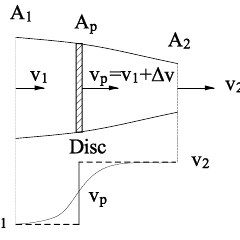
Figure 5. Schematic diagram of speed and pressure before and after the disc.